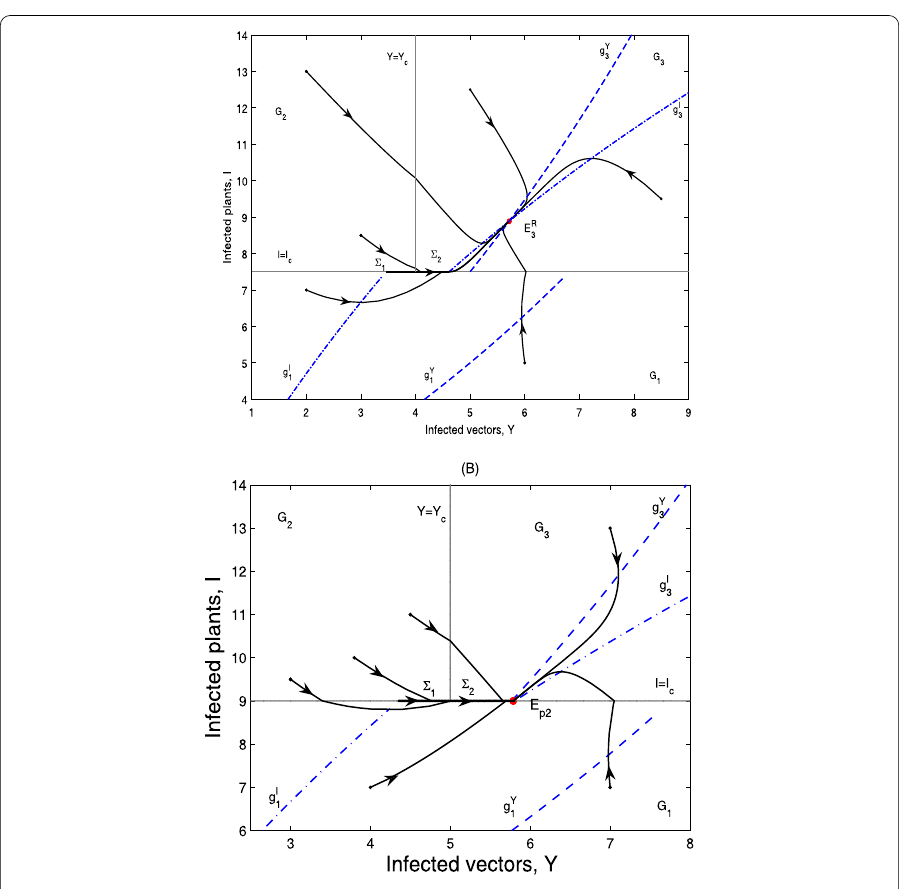
Figure 6 Global dynamics in Case A.22. ( A ) E R 3 is globally asymptotically stable. Y c = 4, I c = 7.5. ( B ) E p 2 is globally asymptotically stable.